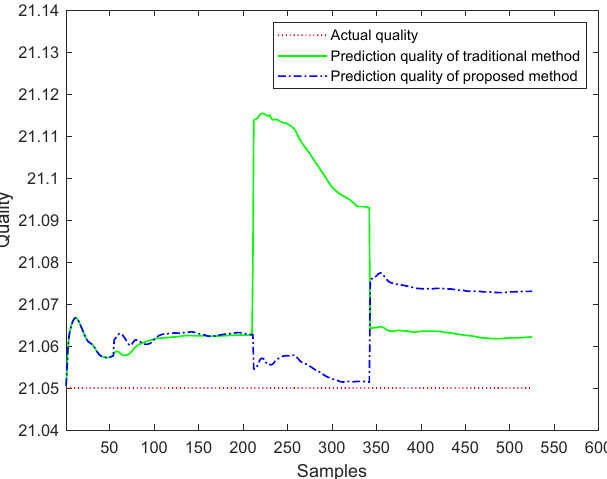
Table 3. RMSE of the different prediction modes in single-mode prediction.